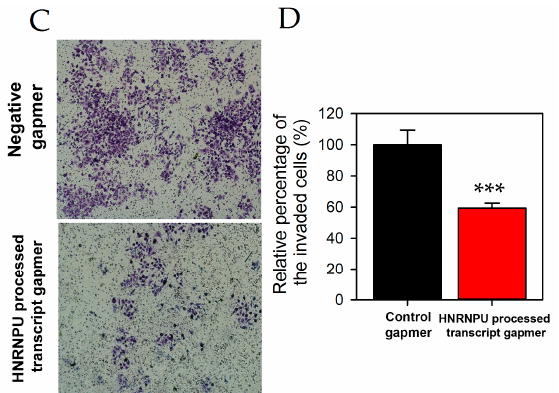
Figure 3. Patu ‐ T cells were treated with 100 nM control or HNRNPU processed transcript gapmer. Figure 3. Patu-T cells were treated with 100 nM control or HNRNPU processed transcript